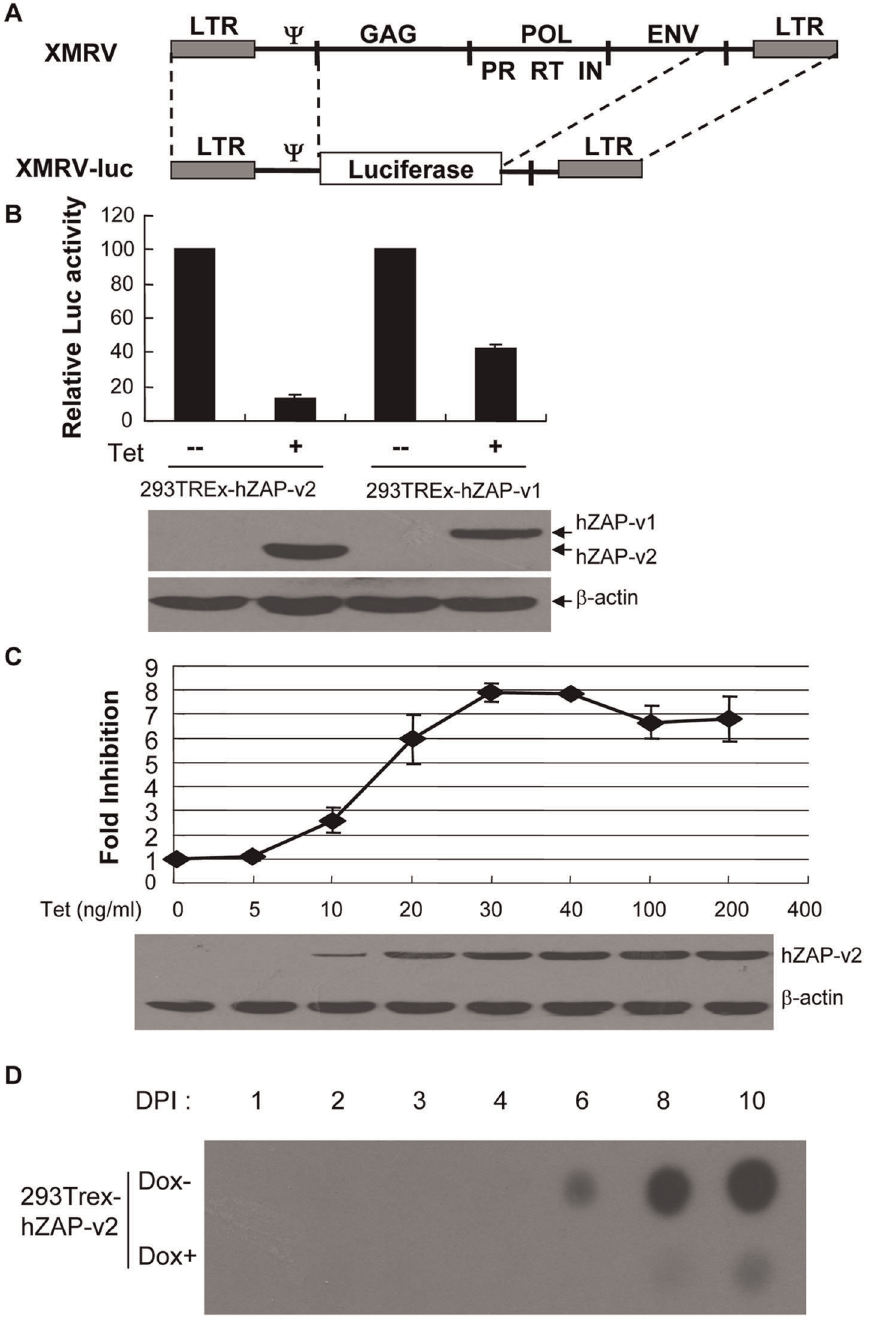
Figure 1. Overexpression of hZAP inhibits XMRV infection. (A) Schematic structure of XMRV-luc vector. The coding sequences of Gag-Pol and part of Envelope were replaced with luciferase-coding sequence to generate pXMRV-luc. (B) Overexpression of hZAP inhibits XMRV-luc infection. 293TRex cells expressing hZAP-v1-myc and hZAP-v2-myc upon tetracycline induction were infected with VSV-G pseudotyped XMRV-luc. Cells were equally divided into two dishes at 6 h postinfection, with one mock treated and the other treated with tetracycline. Cells were lysed and luciferase activity was measured at 48 h postinfection (upper panel). The luciferase activity in the absence of ZAP was set as 100. Data presented are means 6 SD of three independent experiments. The expression of hZAP was confirmed by Western blotting (lower panel). (C) ZAP inhibits XMRV-luc in an expression-level-dependent manner. 293TREx-hZAP-v2 cells were infected with XMRV-luc. At 6 h postinfection the cells were equally split and tetracycline was added to the concentrations indicated. Cells were lysed and luciferase activity was measured at 48 h postinfection. Fold inhibition was calculated as the luciferase activity in mock treated cells divided by the luciferase activity in the tetracycline treated cells (upper panel). Data presented are means 6 SD of three independent experiments. The expression levels of hZAP-v2 were measured by Western blotting (lower panel). (D) ZAP inhibits XMRV replication. 293Trex-hZAP-v2 Cells were infected with XMRV produced in 293T cells. At 8 h postinfection, cells were mock treated or treated with doxycycline to induce hZAP-v2 expression. Samples were taken every day and subjected to RT assays.